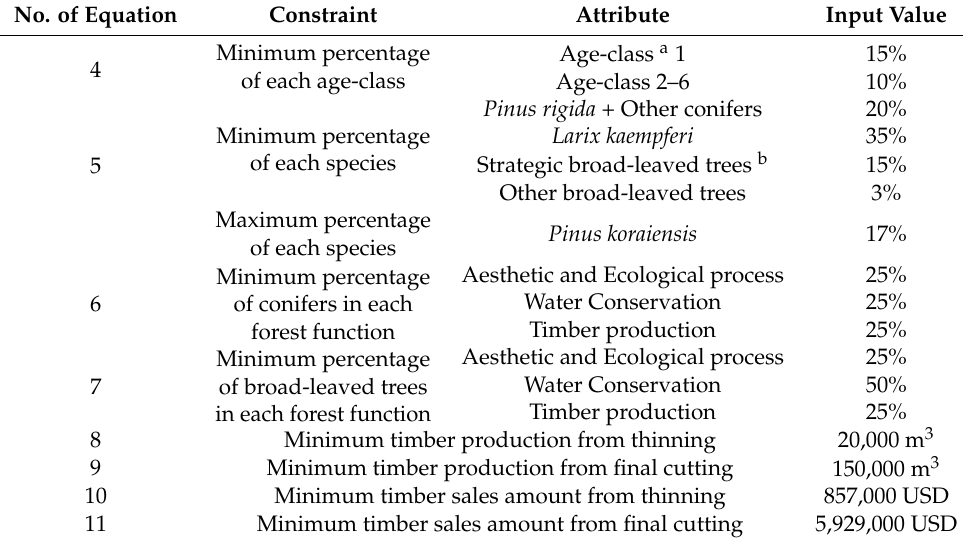
Table 5. Input values of each constraint applied to the MOLP model. Each value was set according to the first Master Plan of Mount Gari’s Leading Forest Management